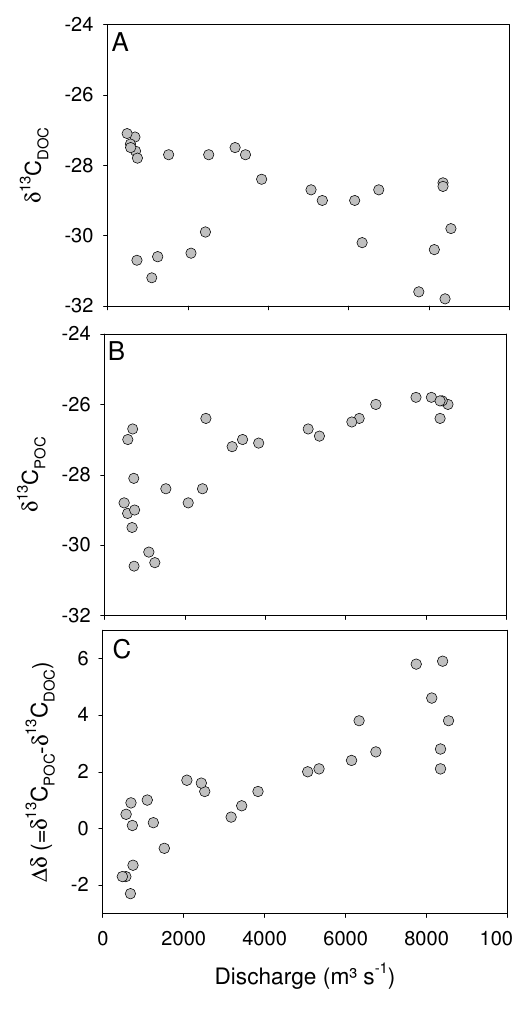
Fig. 6. Relationship between daily discharge and (A) δ 13 C signa- tures of DOC (B) δ 13 C signatures of POC, and (C) 1δ , i.e. the dif- ference between δ 13 C signatures of POC and DOC, in the Oubangui River between March 2010 and March 2011.